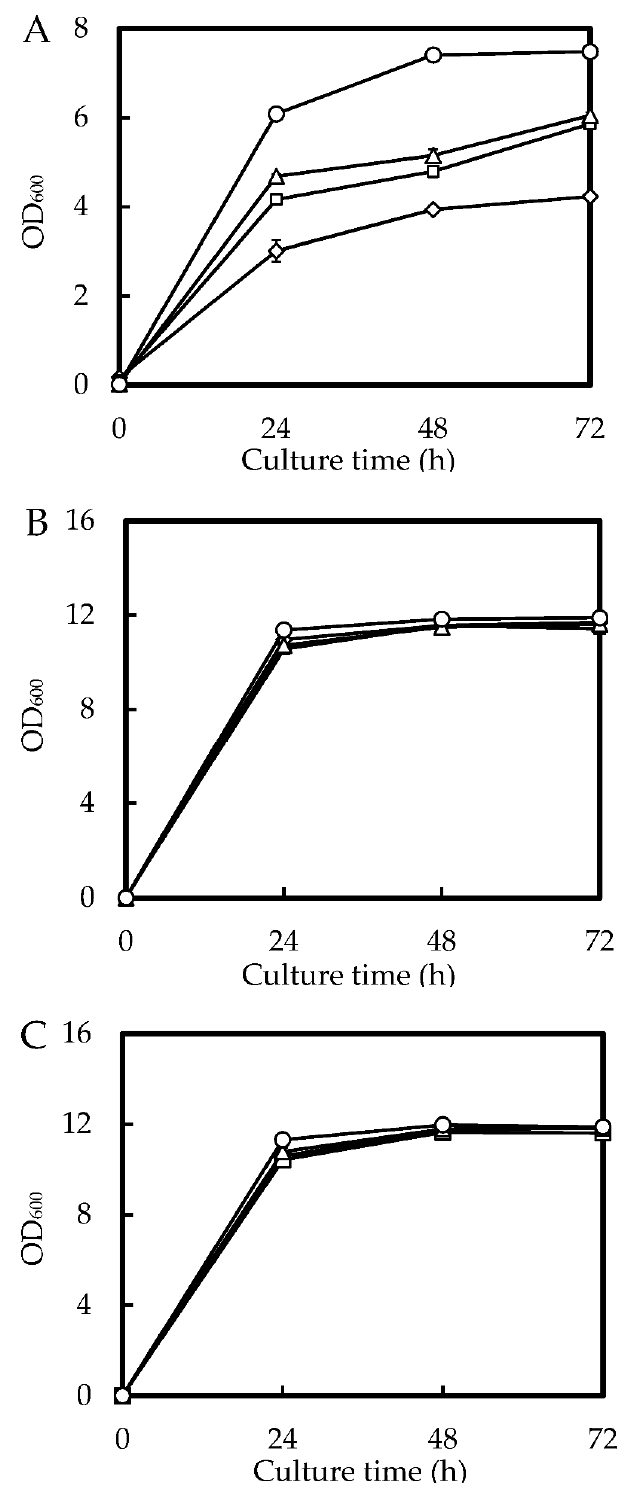
Figure 1. Growth profiles of yeast strains in Dy-containing media. Yeast strains were cultured in medium containing Dy at 0 mM (circles), 0.1 mM (triangles), 1.0 mM (squares), and 10 mM (diamonds) at 30 °C with shaking. ( A ) S. cerevisiae BY4741; ( B ) Alt-OF2; ( C ) Alt-OF5.